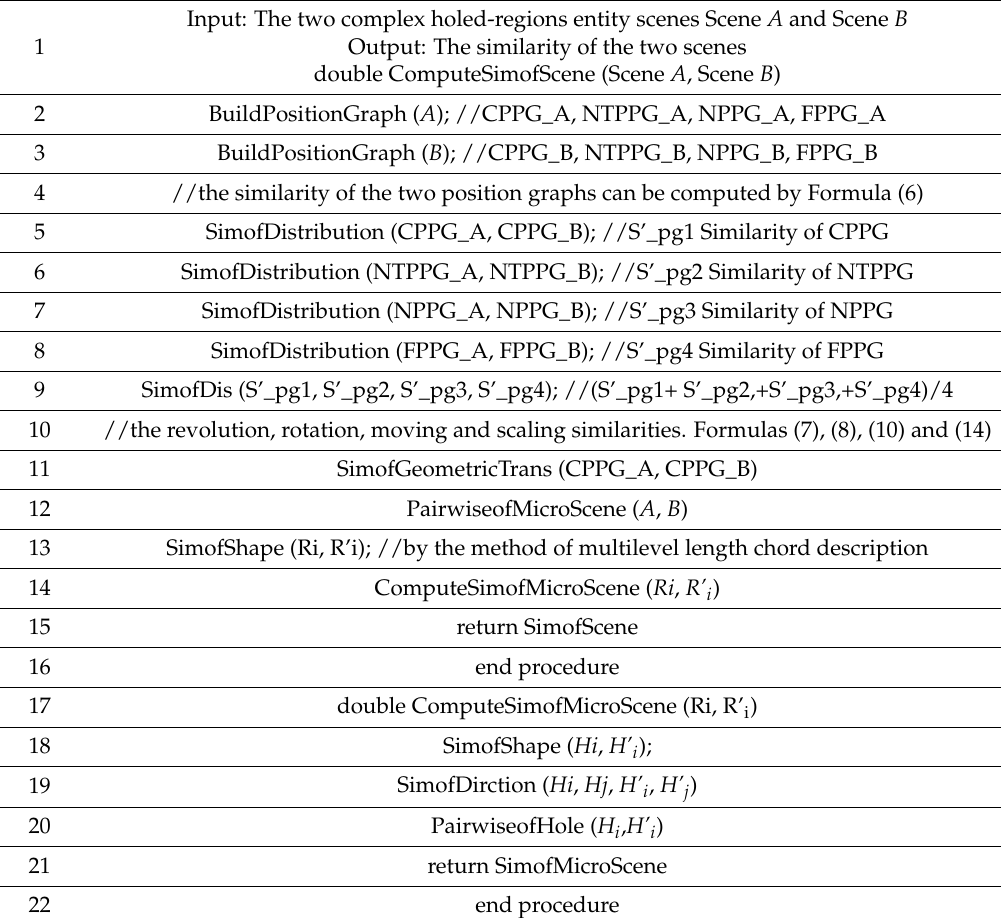
Table 1. Pseudocode for the measurement of complex holed-region entity scene’s